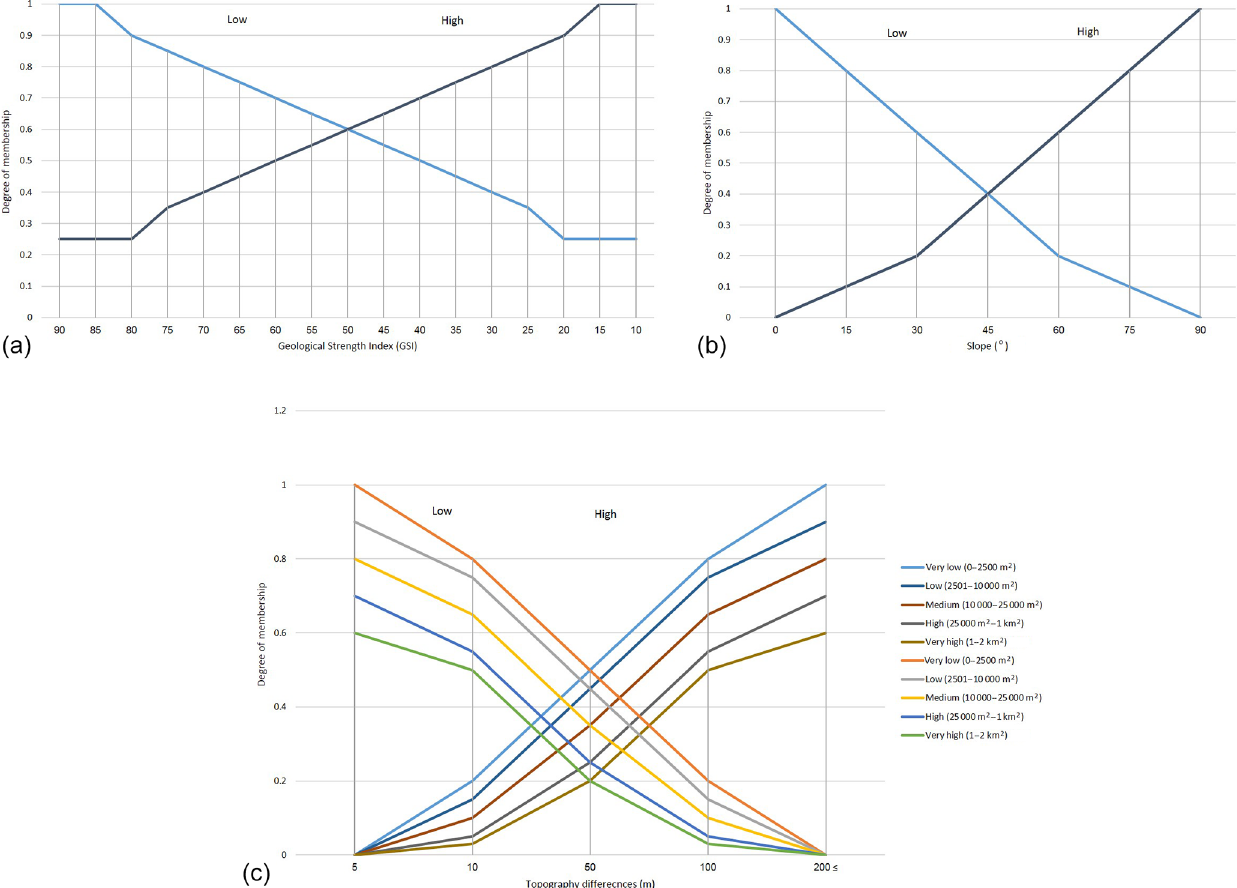
Figure 5. Membership functions (MFs) based on the fuzzy logic system: type of rock and bedrock (a) , slope (degree) (b) , topographic irregularities (c)